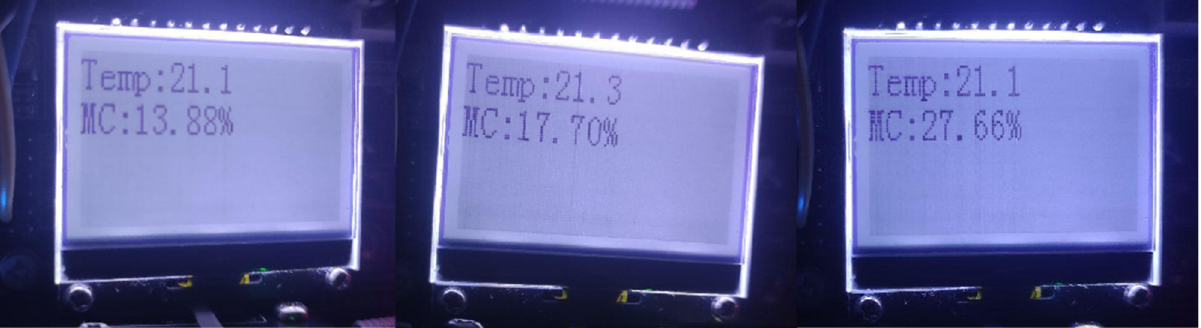
Figure 14. Display of actual moisture content measurement results.